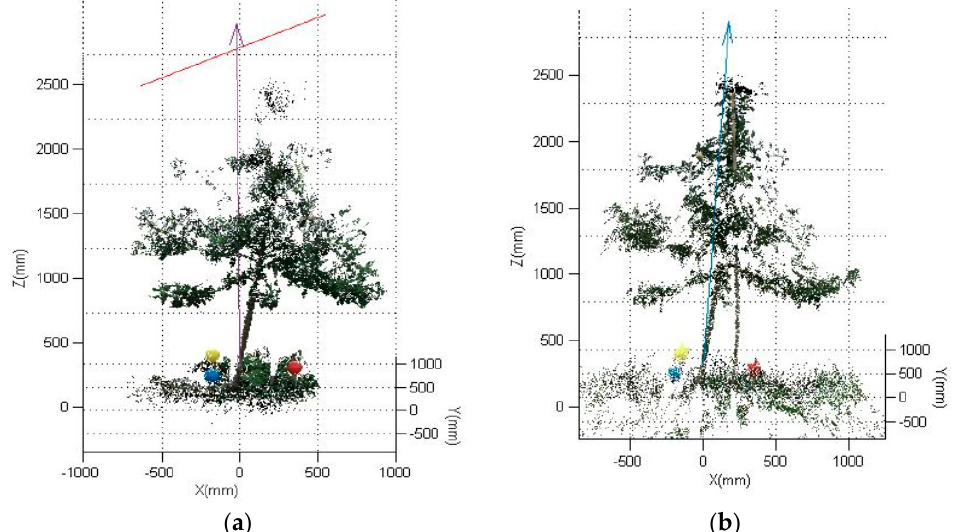
Figure 4. Identification diagram with calibration balls: ( a ) red ball point cloud from the first visual angle; ( b ) yellow ball point cloud from the first visual angle; ( c ) blue ball point cloud from the first visual angle; ( d ) red ball point cloud from the second visual angle; ( e ) yellow ball point cloud from the second visual angle; ( f ) blue ball point cloud from the second visual angle.